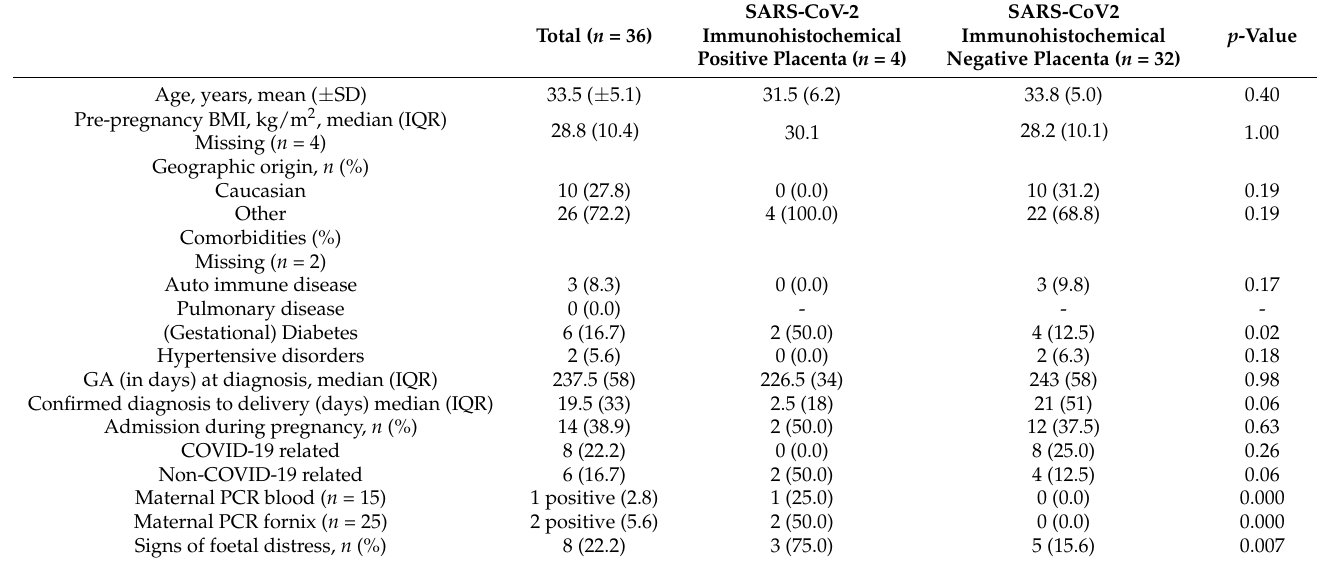
Table 4. Maternal characteristics for the total study population and subgroups positive and negative SARS-CoV-2 immuno- histochemical placentas.